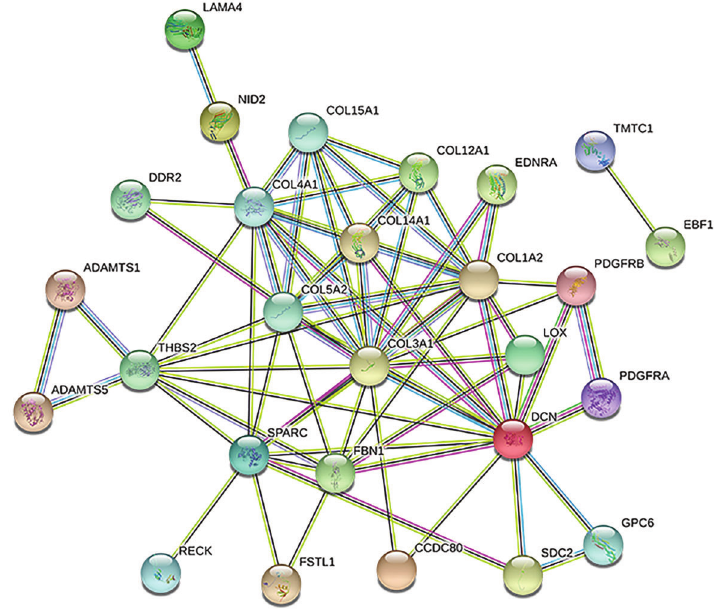
Figure 1. Protein interaction network of ADAMTS5 co-expression